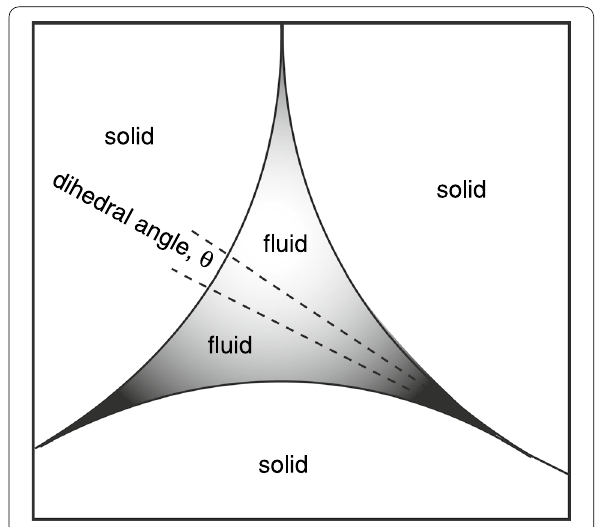
Fig. 33 Schematic illustration of dihedral angle, Θ, in an isotropic medium of solid and fluid